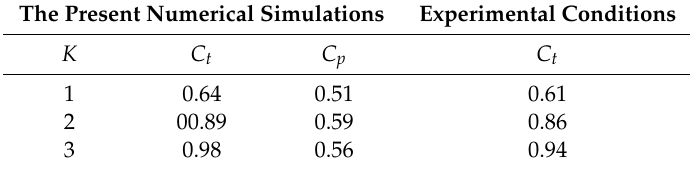
Table 1. Thrust and power coefficients for three resistance coefficients K studied in this paper. The validation of these results is based on a comparison with experimental results that Harrisson [40] obtained for porous disk, with C t close to the values usually obtained for the Betz Limit.